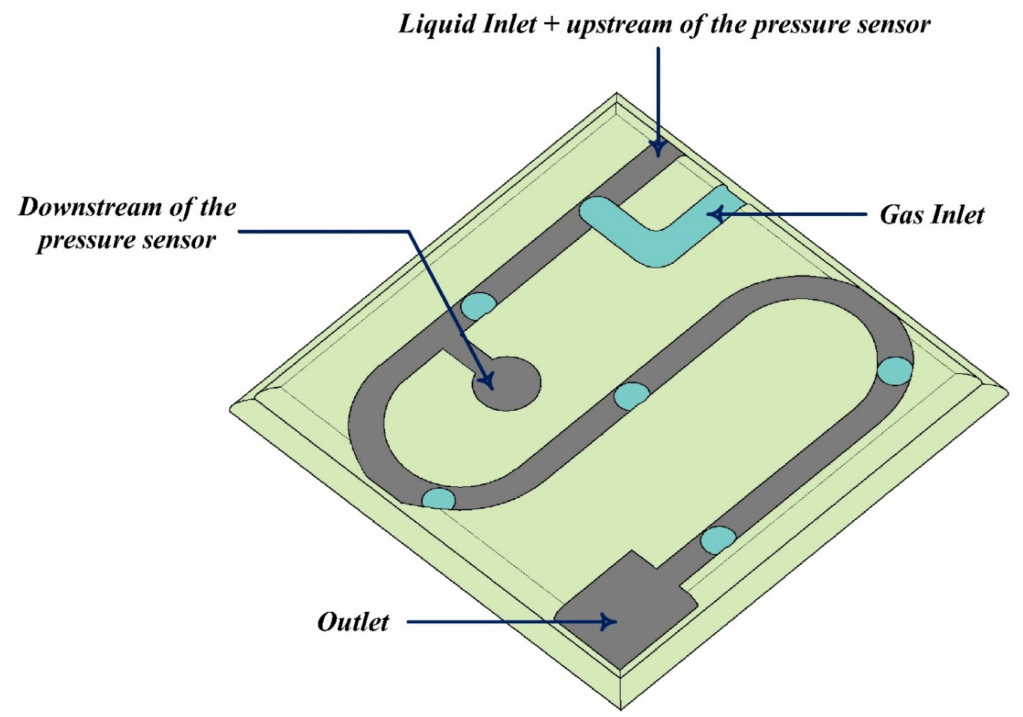
Figure 11. In this experiment, a microchannel was employed. The entire plate is 30 mm × 60 mm × 6 mm. The T-junction is in the upper-left corner, and an auxiliary channel is bored 30 mm downstream to plug the sensor’s low-pressure side.